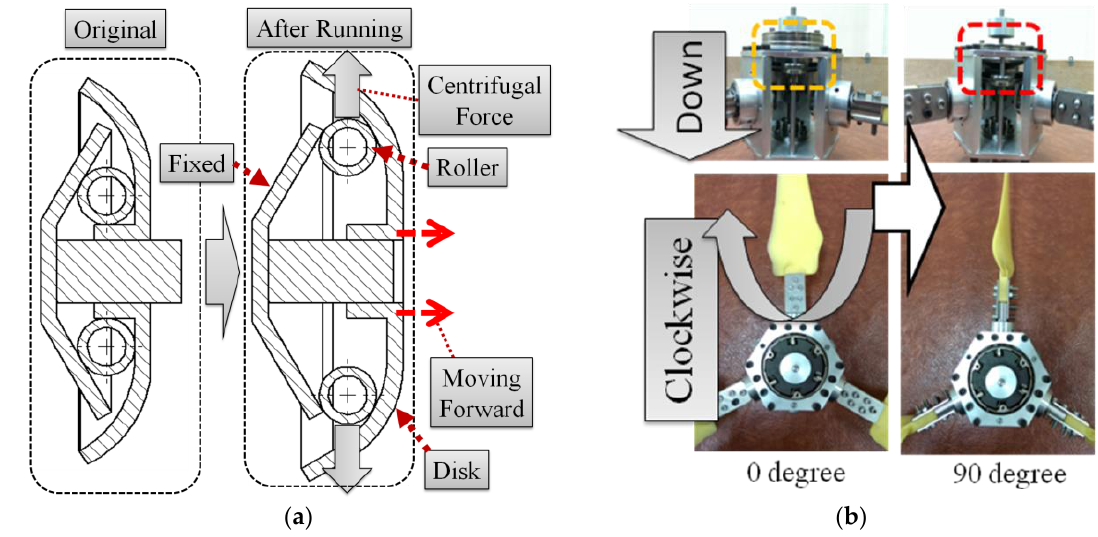
Figure 8. Mechanism of the passive pitch control: ( a ) cross-section of the design; and ( b ) blade motion of the prototype.